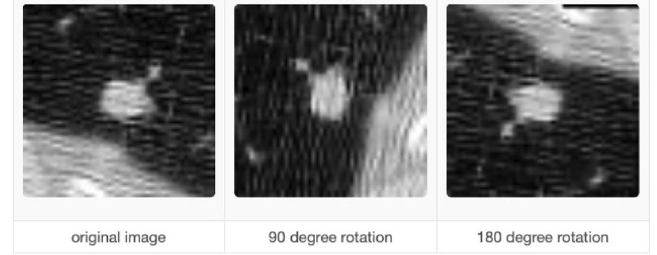
Figure 3. Cropped CT scan